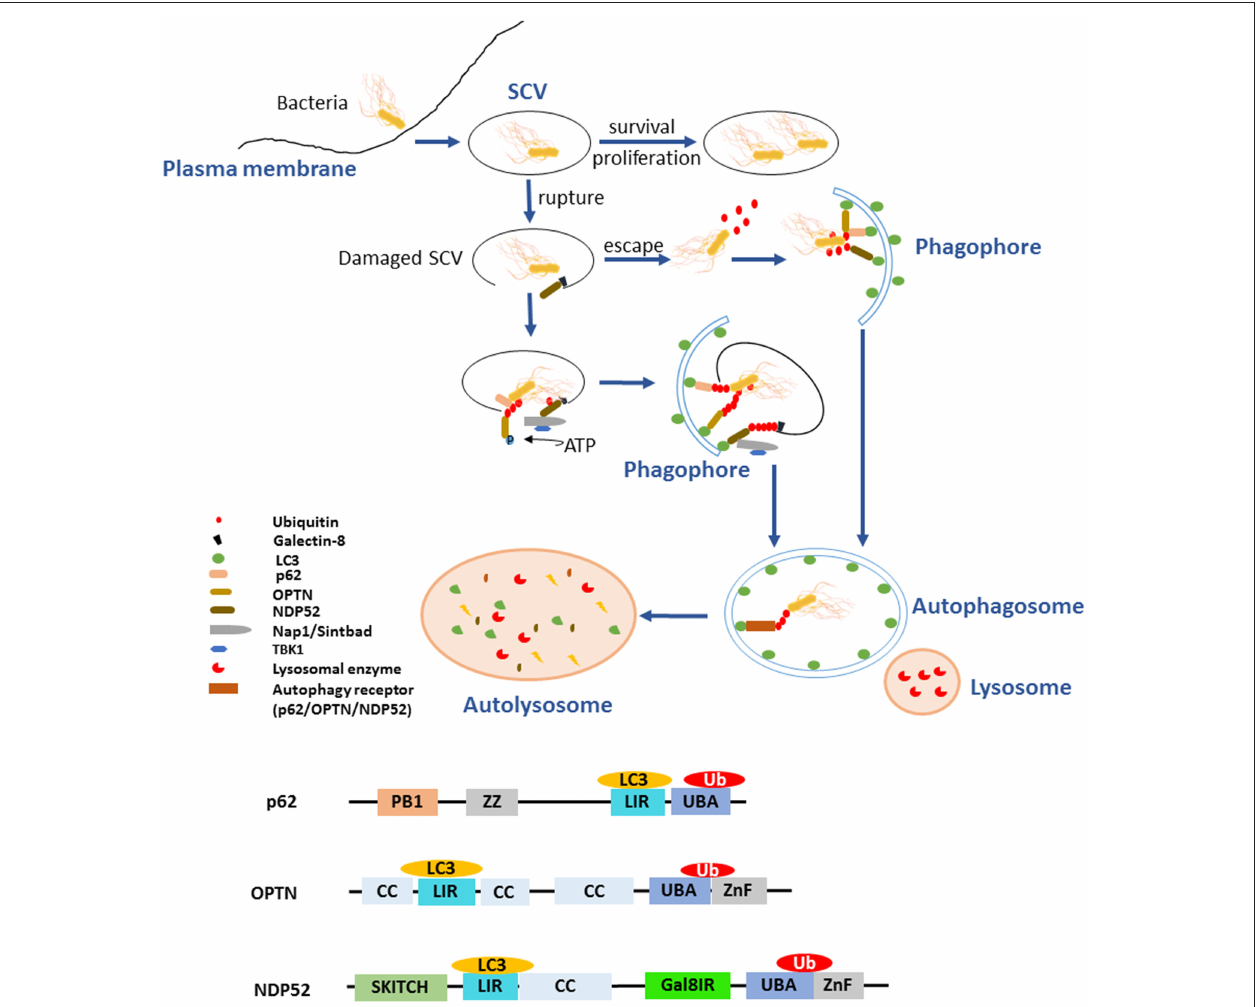
FIGURE 1 | Ubiquitination and autophagy during Salmonella infection. After invading into host cells, Salmonellae reside in Salmonella -containing vacuoles (SCVs), the modified phagosomal compartment. There are different endings for the bacteria depending on the integrity of SCVs. The SCVs are the protective compartment for Salmonellae survival and proliferation, while they could be damaged by needle-like apparatus T3SS-1. With the SCVs ruptured, a portion of Salmonellae escaped and exposed to the cytoplasm. Cytosolic bacteria are ubiquitinated rapidly as a “eat-me” signal leading to the recruitment of autophagy receptors such as p62/SQSTM1, OPTN, and NDP52 to initiate the process of autophagy and being degraded. The remaining bacteria in the damaged SCVs can also be eliminated by autophagy with another “eat-me” signal, the exposed galectin-8. When the integrity of SCVs is lost, exposure of galectin-8 can recruit autophagy receptor NDP52. NDP52 binds the adaptor proteins Nap1 and Sintbad and recruits TBK1 nearby the cytosol-exposed bacteria, TBK1 phosphorylates OPTN thereby leading to enhanced affinity for LC3 and initiates autophagy. All the autophagy receptors p62, OPTN, and NDP52 contain LC3-interacting region (LIR) and ubiquitin-associated (UBA) domain, which bridge Ub-coated bacteria to the autophagy modifiers LC3. In addition, the receptors with special domain enrich their function on autophagy process. ZZ domain of p62 can promote the delivery of itself and cargos to the autophagosomes. Gal8IR region of NDP52 is involved in the recognition of autophagy.